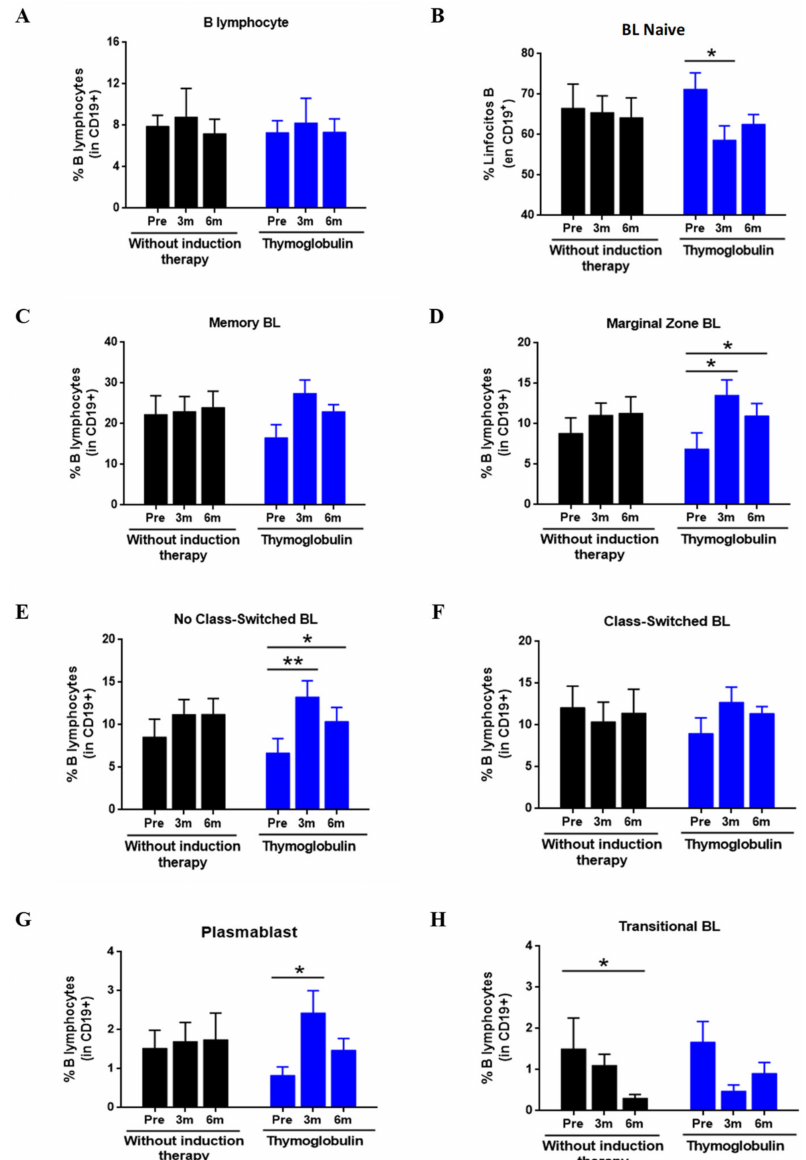
Figure 7. Effect of thymoglobulin on B lymphocyte subpopulations in pre- and post-transplant. The figure shows the relative frequencies of the BL subpopulations in RTR administered thymoglobulin (Blue bars, n = 12) and did not receive induction therapy (Black bars, n = 19). The values show mean ± SEM. The comparison within each group between pre-transplant and post-transplant values was performed using the Wilcoxon test for related samples. The comparison at each time between the group without induction and the thymoglobulin group was carried out using the Mann–Whitney U test. Values of p < 0.05 were considered statistically significant. * p < 0.05; ** p < 0.01. Abbreviations: NBL, Naive B Lymphocytes; TLB, Transitional B Lymphocytes; MBL, Memory B Lymphocytes, CSBL, Class-Switched B Lymphocytes; NCSBL, Non-Class-Switched B Lymphocytes, MZBL, Marginal Zone B Lymphocytes; PLAS, Plasmablasts. GF, glomerular